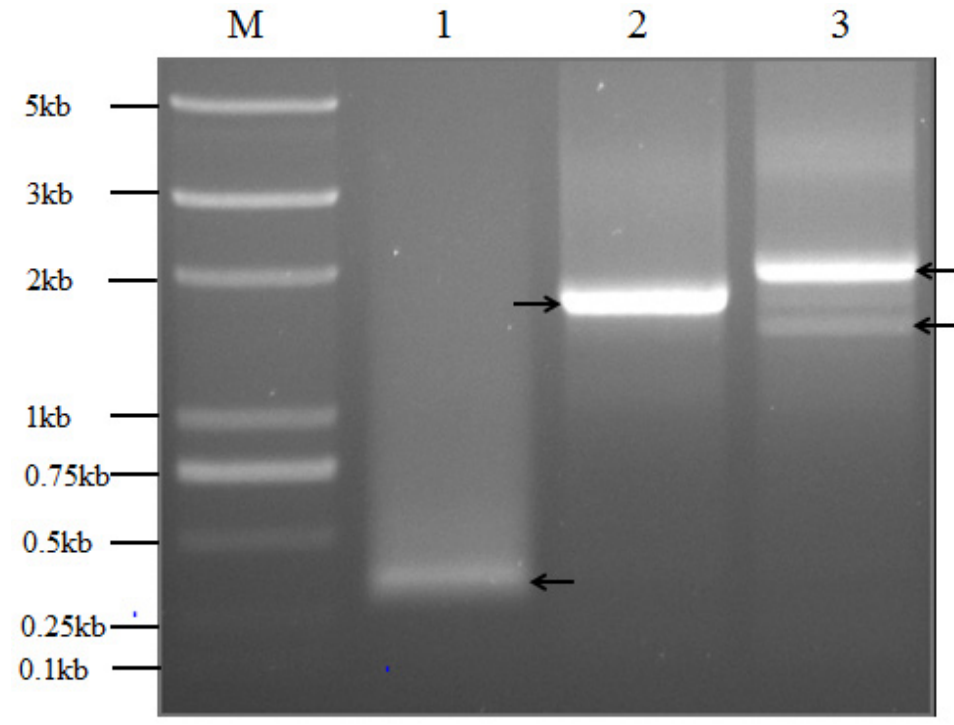
::GUS line; and ( 3 ) Wip ::GUS 1231 1737